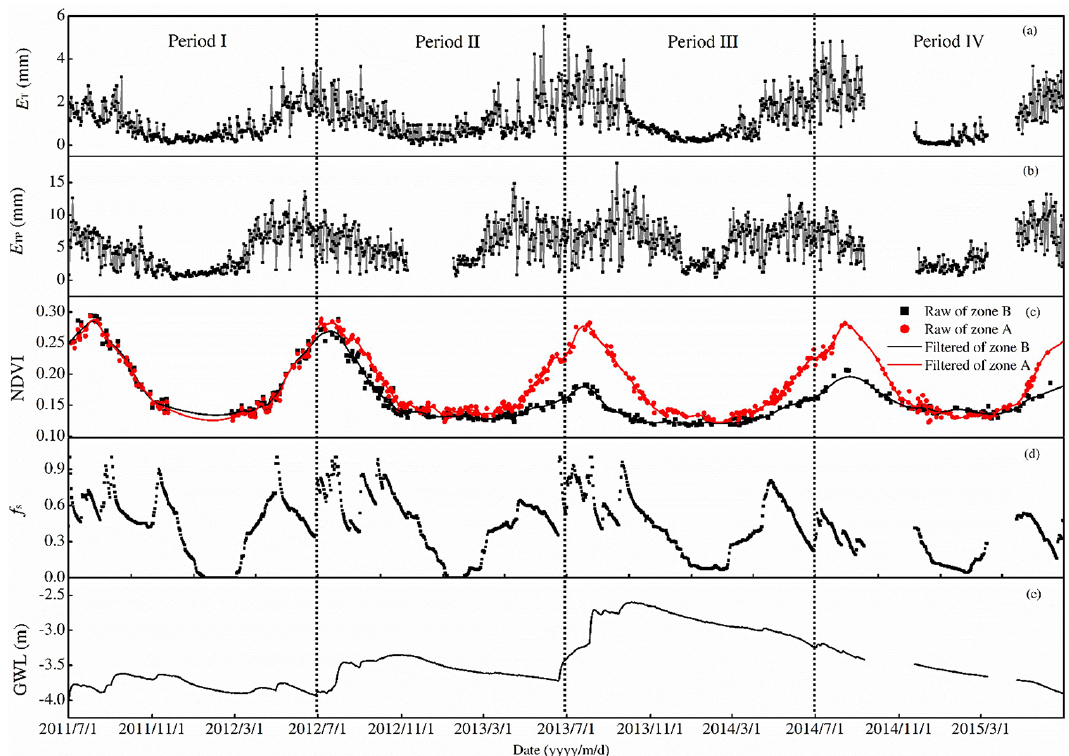
Figure 5. Seasonal and inter-annual characteristics of daily (a) evapotranspiration ( E T , mm); (b) potential evapotranspiration ( E TP , mm); (c) NDVI in zone A and zone B within the footprint; (d) the soil water stress of the root zone ( f s ) ; and (e) the groundwa- ter level (GWL, m) from 1 July 2011 to 30 June 2015.